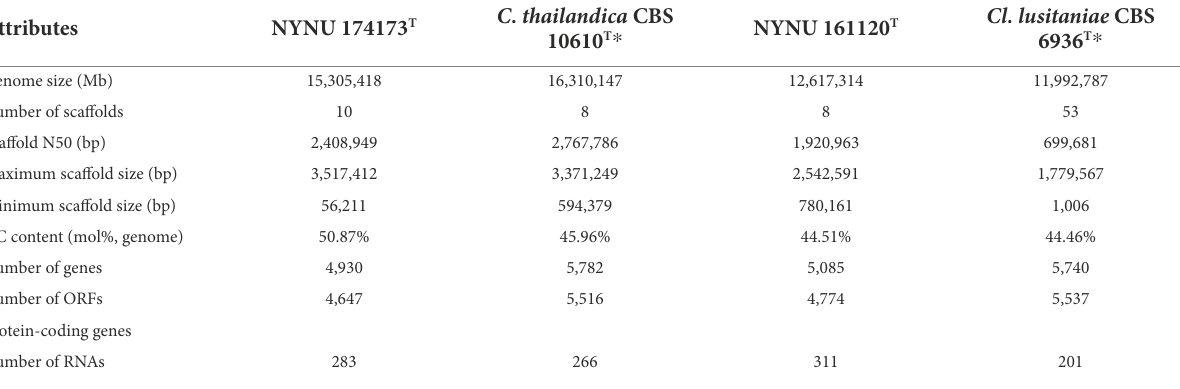
TABLE 4 Genome properties for strains NYNU 174173 T and NYNU 161120 T and for the type strains of the most closely related species in the Clavispora clade.